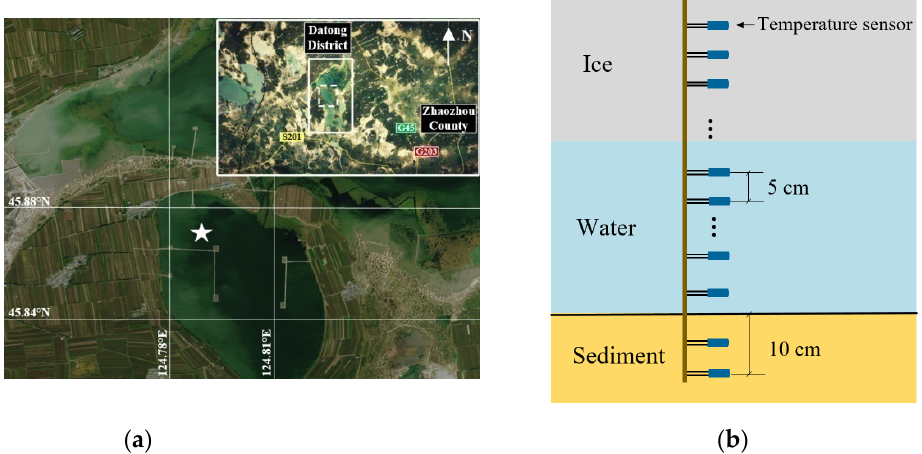
Figure 1. Observation site and schematic diagram of layout. ( a ) Observation site, ( b ) Schematic diagram of temperature chain layout.